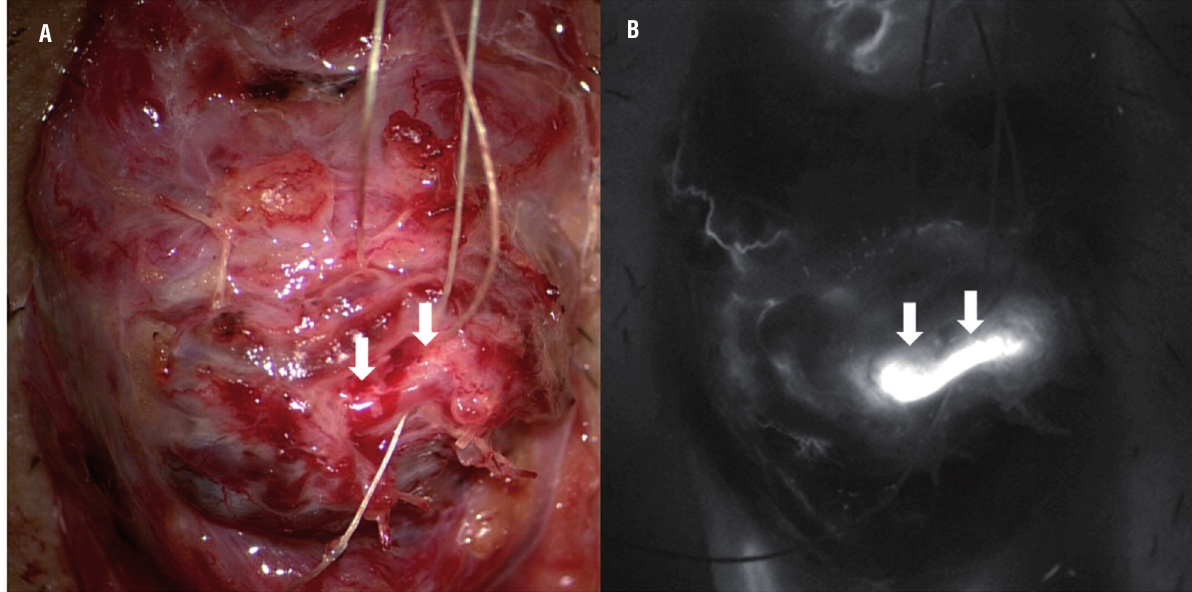
Figure 3 - Intraoperative indocyanine green angiography may facilitate early identification of testicular artery. A) Microscopic view showing dense adhesions among intermingled artery and dilated veins which render the identification of arterial pulsation extremely difficulty. B) Indocyanine green angiography showed a single testicular artery among the densely adhered